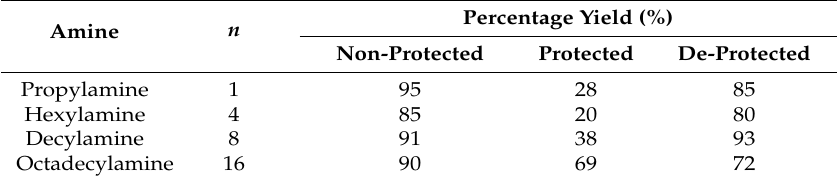
Table 1. Percentage yields of the n -phenyl– n -alkyl ureas of for pure, protected and de-protected amine. Amine